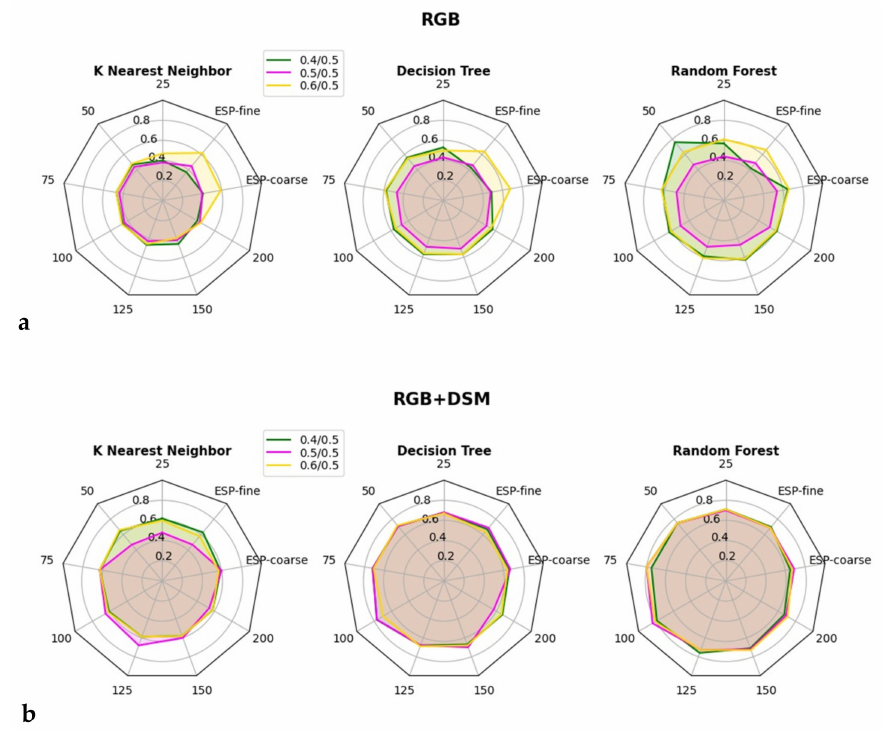
Figure 9. Radar plots are illustrating models’ agreement performances (no agreement: cen- ter; full agreement: perimeter) in relation to the investigated SP values for ( a ) RGB and ( b ) RGB+DSM